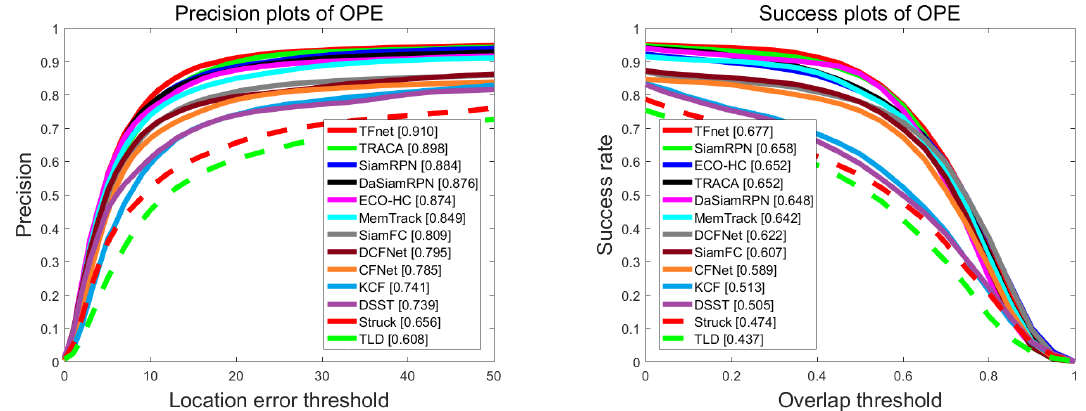
Figure 4. Distance precision plot and overlap success rates plot using one-pass evaluation on the OTB2013